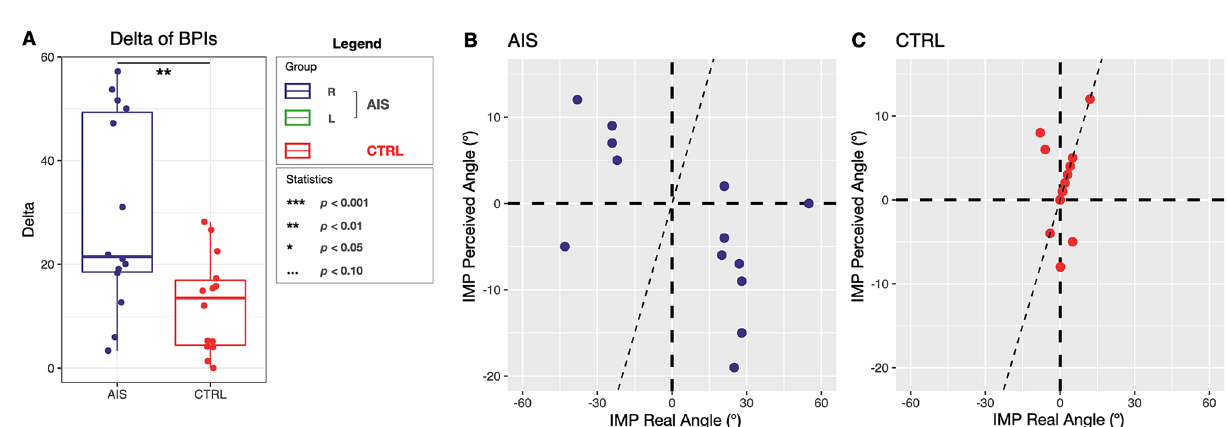
Figure 5. ( A ) BPI delta values defined as the difference between shoulder BPI and waist BPI . A significant difference emerged between mean delta BPIs of adolescents with AIS and controls ( p < 0.01 ). ( B,C) ) On the x axis are plotted the real angles as measured with IMP while on the y axis the perceived angles as measured with IMP. To characterize curve laterality, we assigned positive values when curves’ convexity was right-oriented, and negative values when left-oriented. ( B ) In the adolescents with AIS 12 out of the 14 girls perceive their curve orientation as opposite to the real one. ( C ) For the control group, just 3 out of 14 girls perceive their curve orientation as opposite to the real Theta band activity intensifies when control demands are increased 37 ; it is reported to rise with increasing